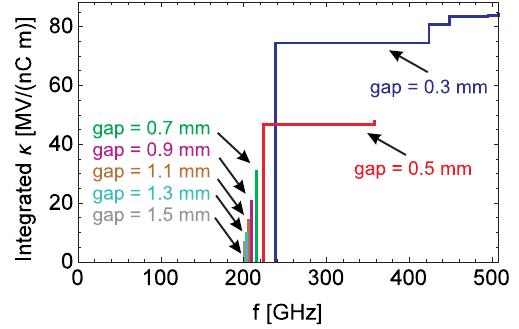
FIG. 9. Integrated loss factors for the TW structure, with σ ¼ 50 μ m, for all the analyzed gaps, with the electron beam z on axis.